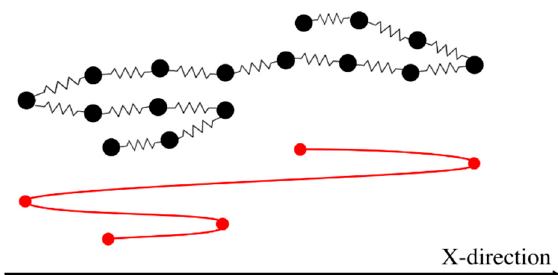
Figure 11. Schematic of mapping of a bead-spring chain into a kinked conformation. The chain has five kinks, including the first and the last beads.